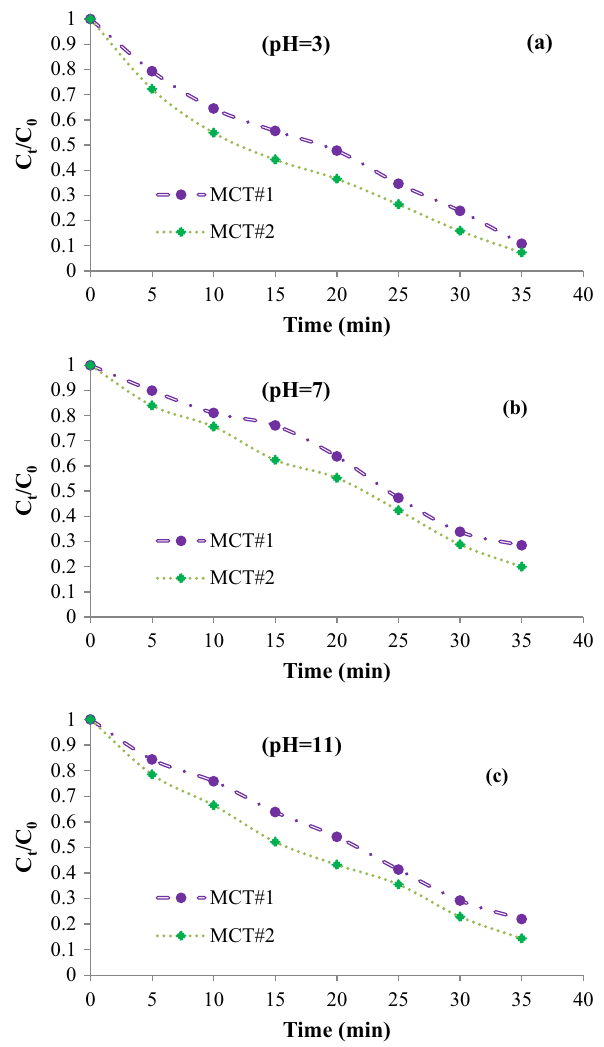
Fig. 7 Comparison between MO concentration changes over time using MCT#1 and MCT#2, at distinct pH, a : pH = 3, b : pH = 7, c : pH = 11